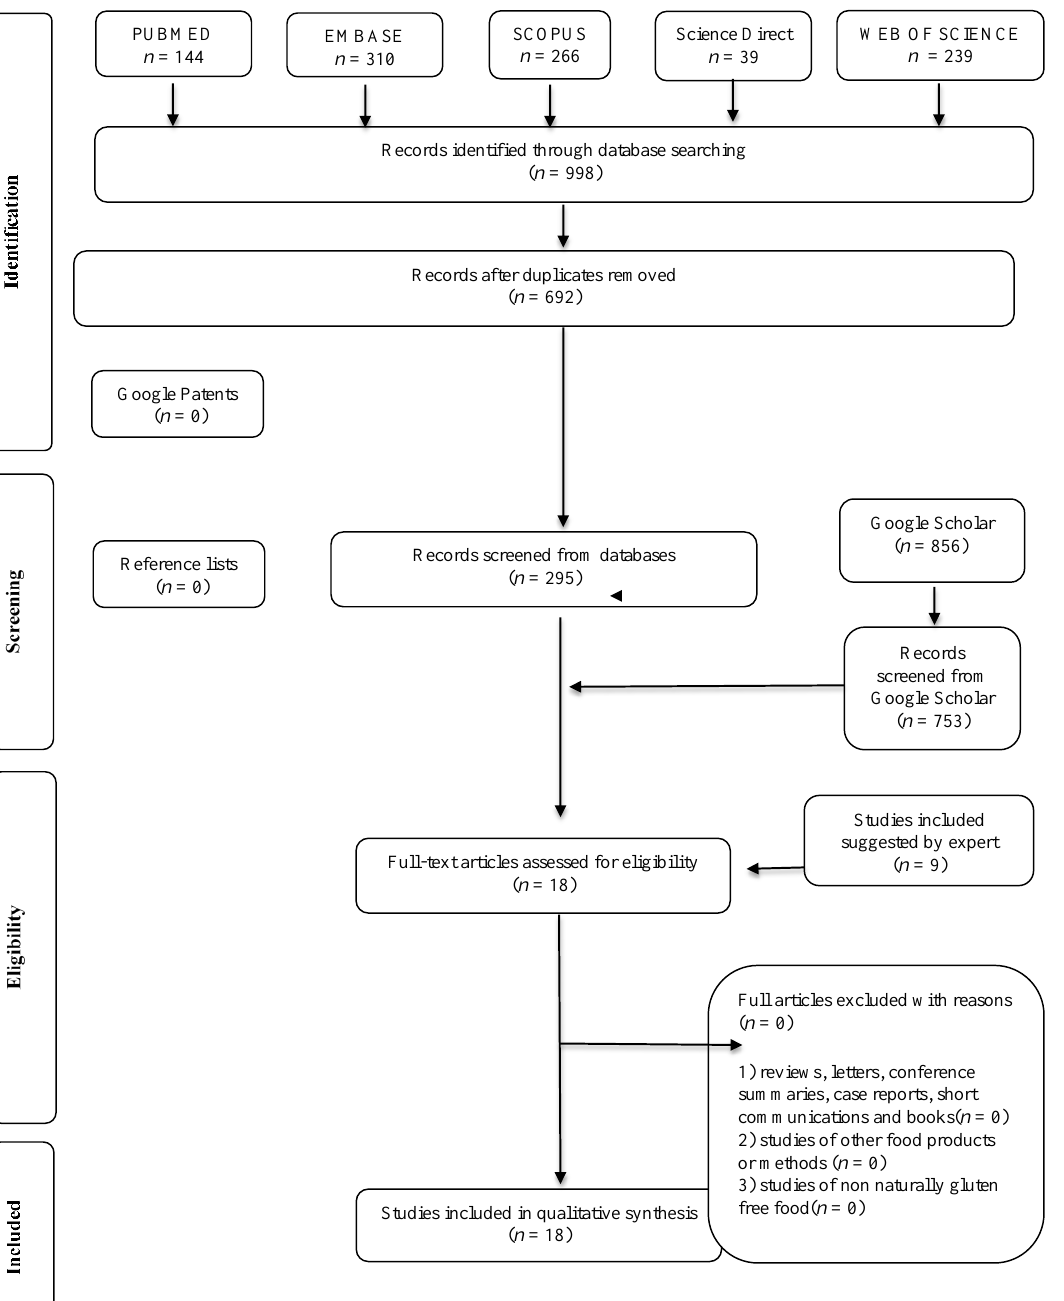
Figure 1. Flow Diagram of Literature Search and Selection Criteria.